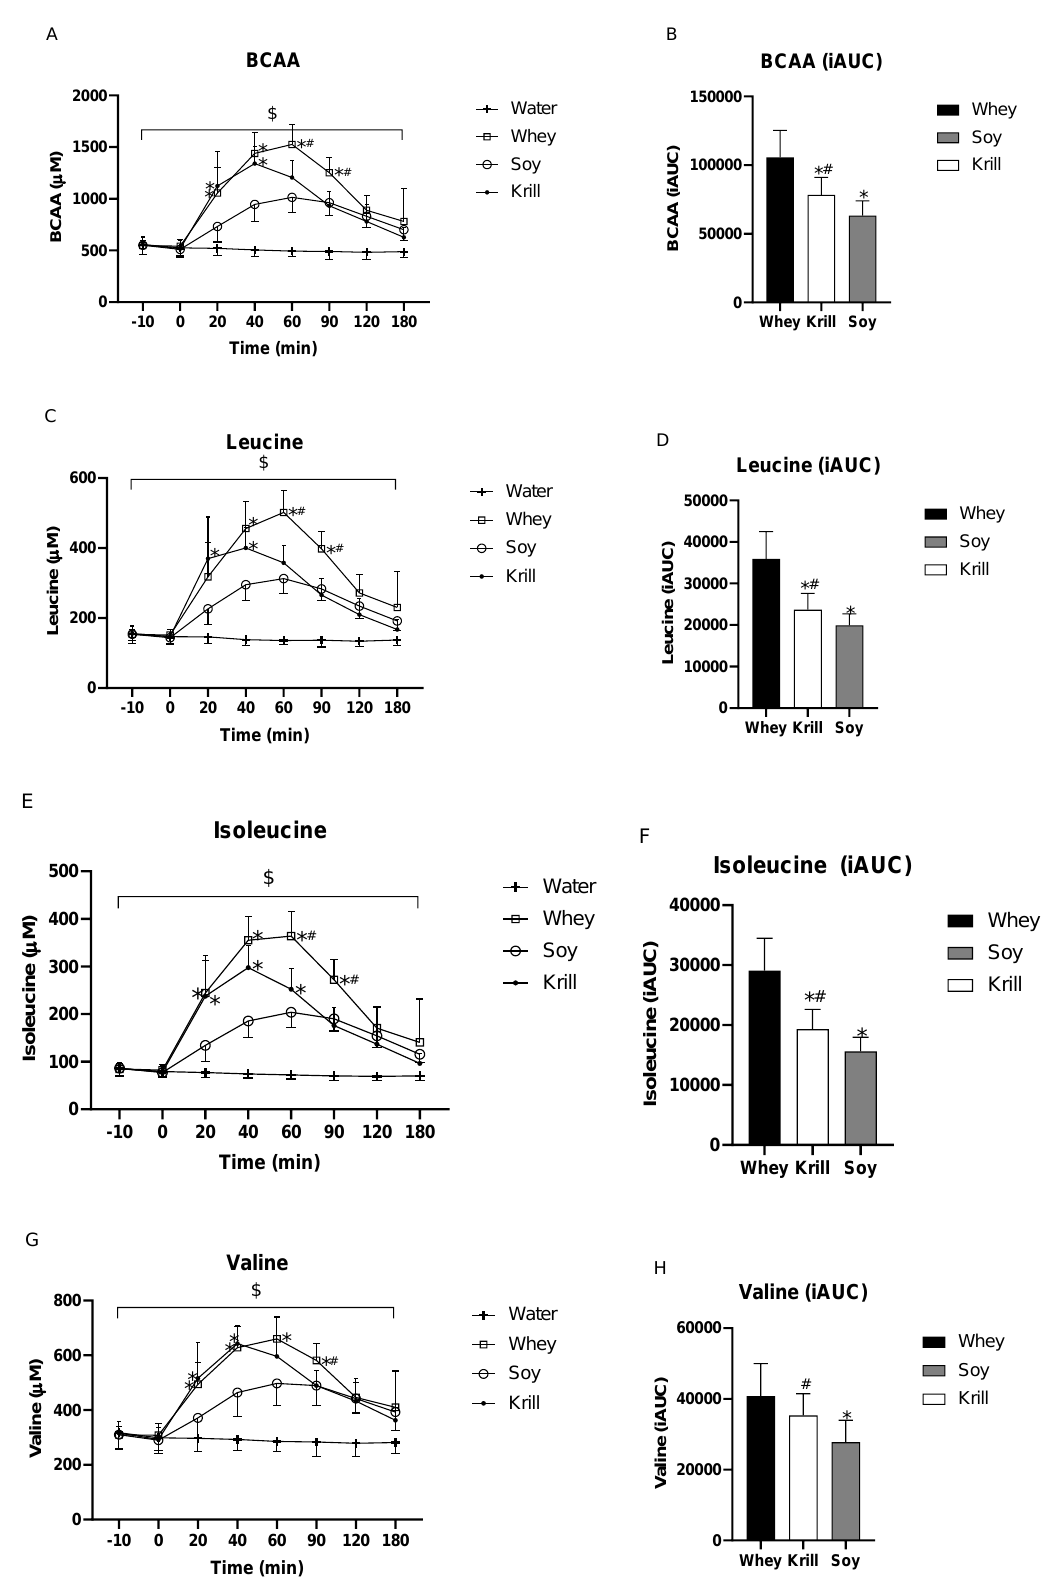
Figure 3. Postprandial serum concentrations of total ( A ) branched chain amino acids (BCAAs), ( C ) leucine, ( E ) isoleucine, ( G ) valine and incremental area under the curve (iAUC) analyses for total ( B ) BCAAs, ( D ) leucine, ( F ) isoleucine and ( H ) valine. $ p < 0.001 time × treatment interaction. For Figure 3A,C,E,G: * significantly different from SOY, # significantly different from Krill. For Figure 3B,D,F,H: * p < 0.05 compared to WHEY, # p < 0.05 KRILL compared to